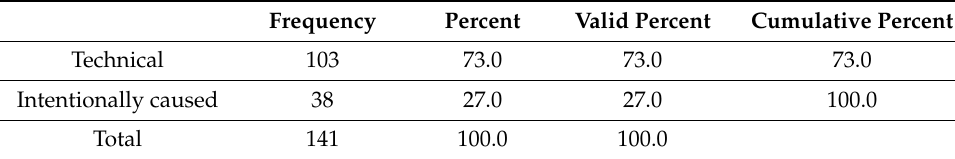
Table 11. Recorded incidents by incident